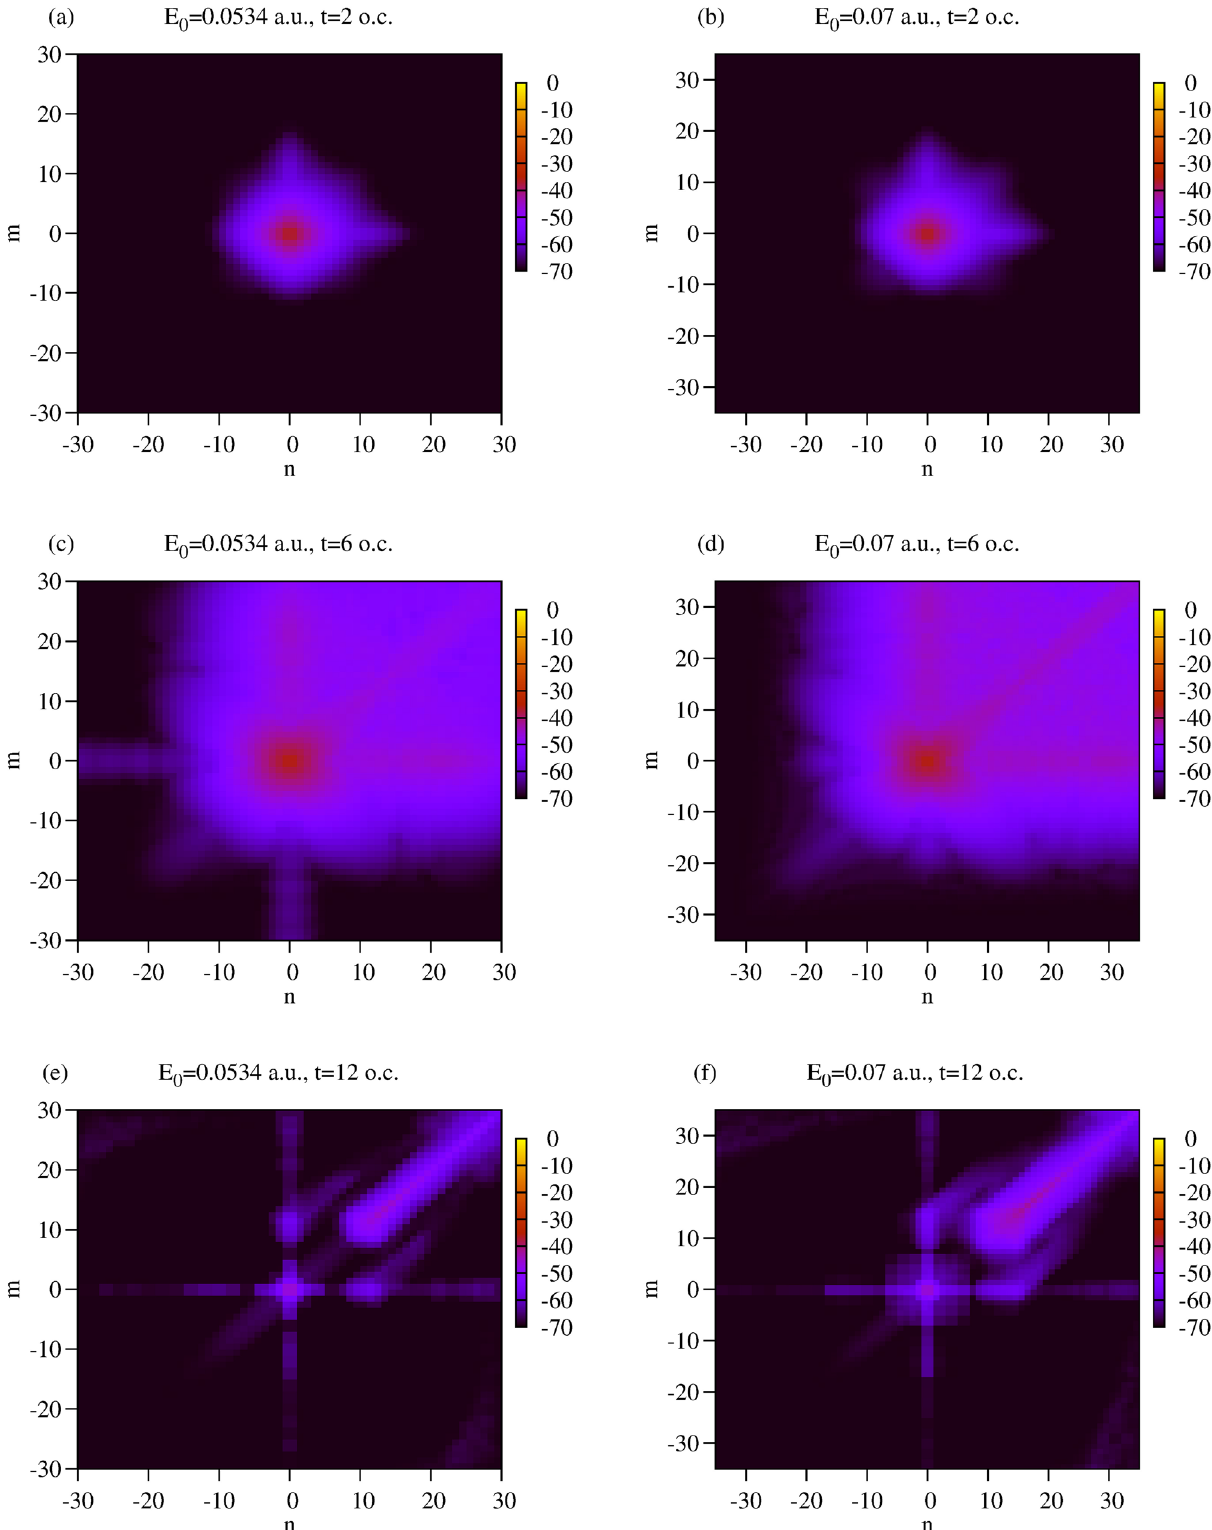
ρ N 0 − n , N 0 − n F . Logarithmic scale is ˆ